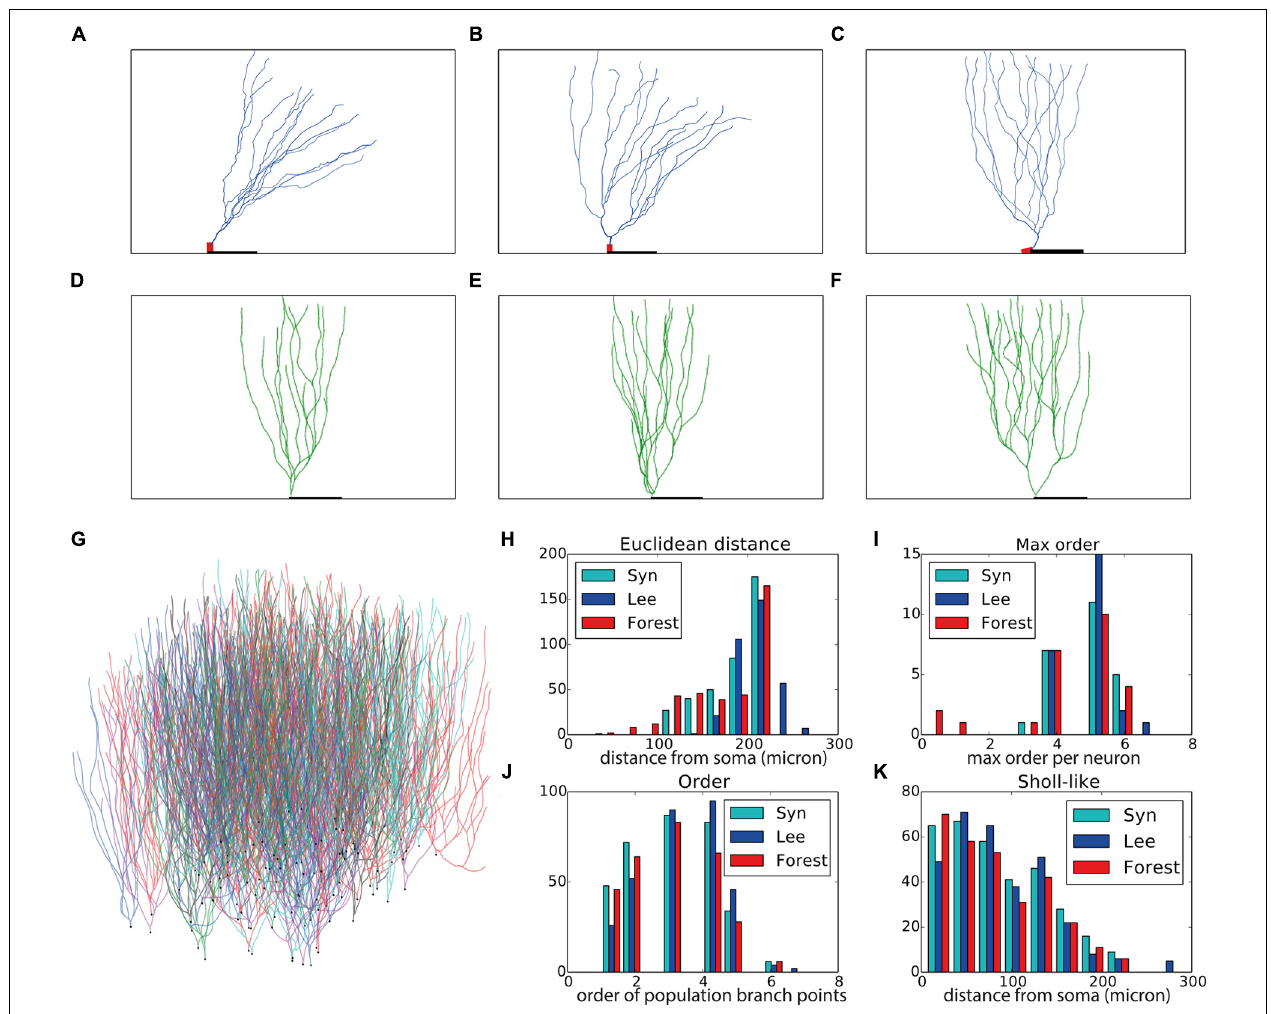
FIGURE 3 |Validation of generated hippocampal granule cells. (A–C) Experimentally reconstructed granule cells (from the Lee archive; Carim-Todd etal., 2009). (D–F) Virtual morphologies generated by NeuroMaC. (G) Forest of 100 simultaneously generated, non-overlapping granule cells. (H–K) Quantitative comparison. Population morphometrics are shown for the Lee archive (“Lee”), synthetic neurons generated in isolation (“Syn”) and as part